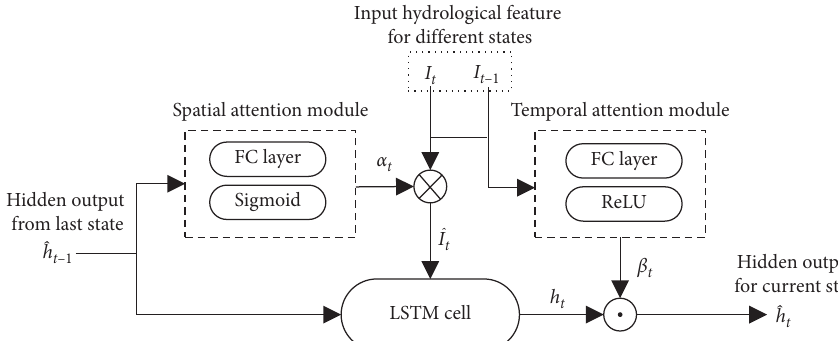
Figure 4: Architecture of the proposed spatial-temporal attention module.